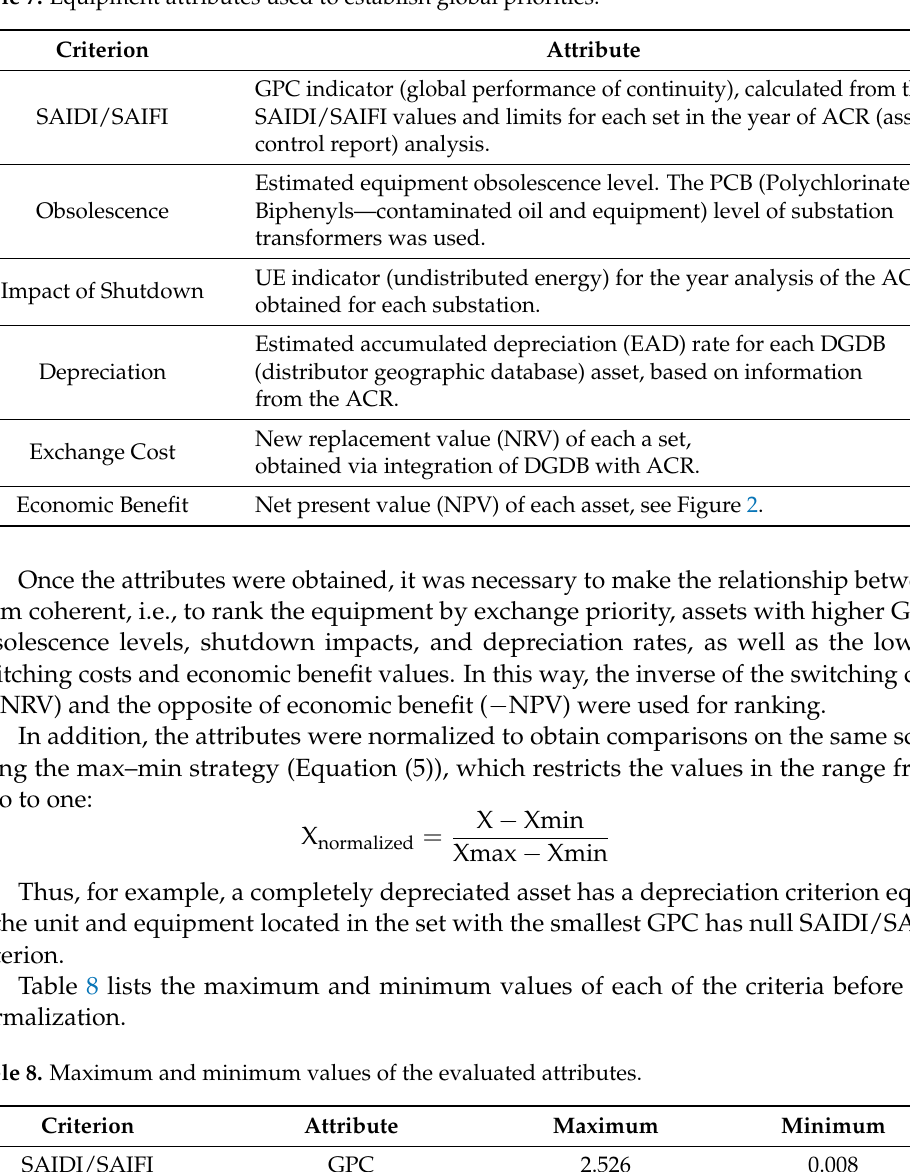
Table 7. Equipment attributes used to establish global priorities.